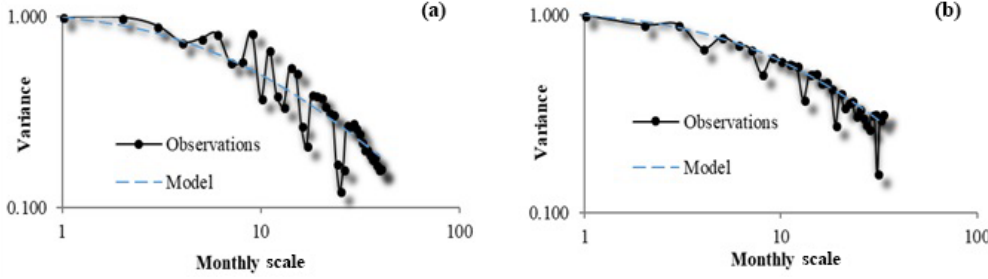
Figure 5. Climacogram for water temperature in two different stations in Florida (SSW28” and DSW40”